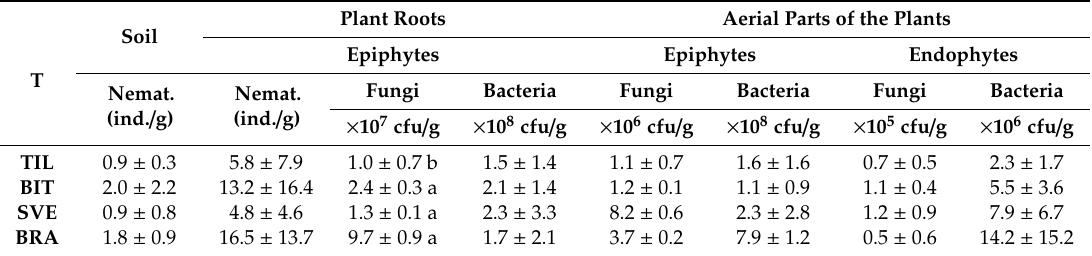
Table 4. Population sizes of nematodes, fungi, and bacteria in soil and / or plants (roots and aerial parts) for the di ff erent treatments.